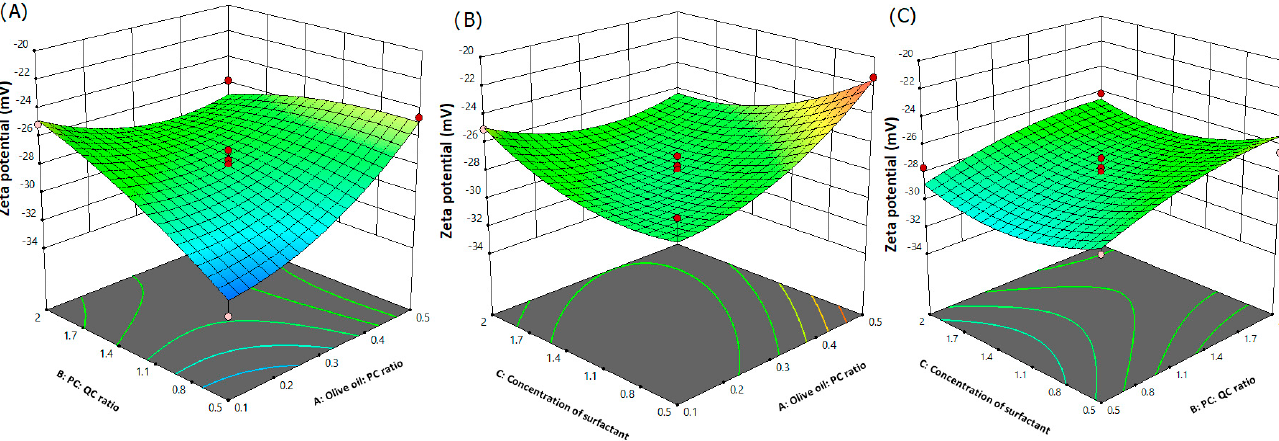
Figure 3. Three-dimensional response surface plots indicating the combined influence of: ( A ) olive oil/PC and QC/PC ratios, ( B ) olive oil/PC ratio and concentration of surfactant and ( C ) QC/PC ratio and concentration of surfactant on zeta potential.